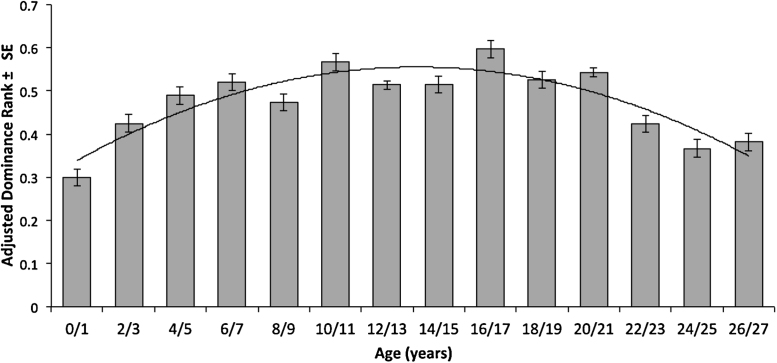
The quadratic relationship between age and dominance rank (adjusted for herd size, d). The line represents the quadratic equation age = −0.005d2 + 0.0757d + 0.2688. R2 = 0.79094.